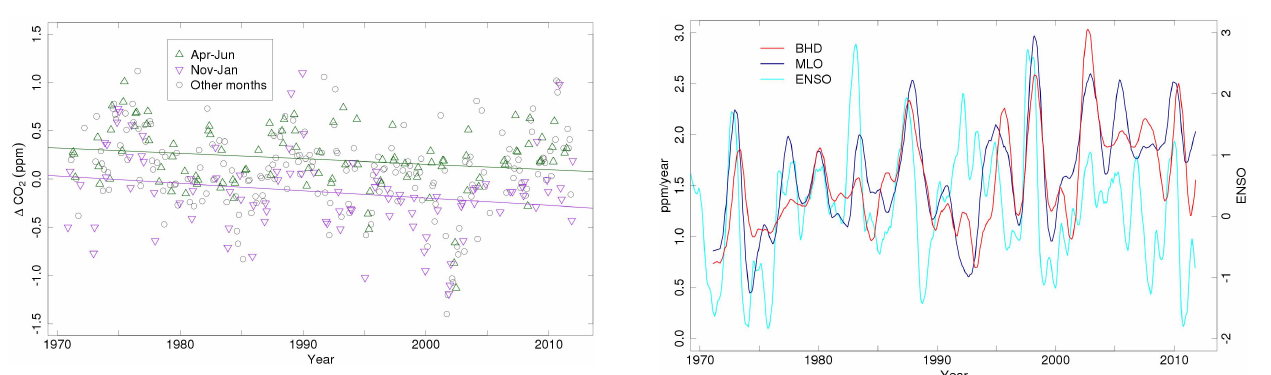
Fig. 9. Baring Head and Mauna Loa CO 2 growth rate and the Mul- tivariate ENSO Index (Wolter and Timlin, 1993). The growth rates were calculated from the month-to-month change in the sum of the trend and interannual components of the STL fits to each record (Fig. 4a and b for BHD). All three time series have been smoothed with a 5-month running mean for clarity. The fits include data prior to December 1972 from the Makara